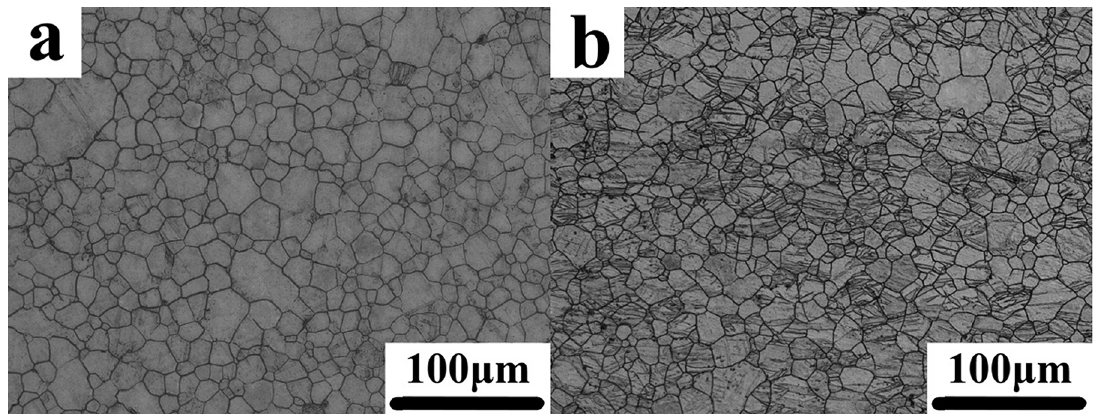
Figure 2. OM micrographs of specimens. (a) as-ND; (b)